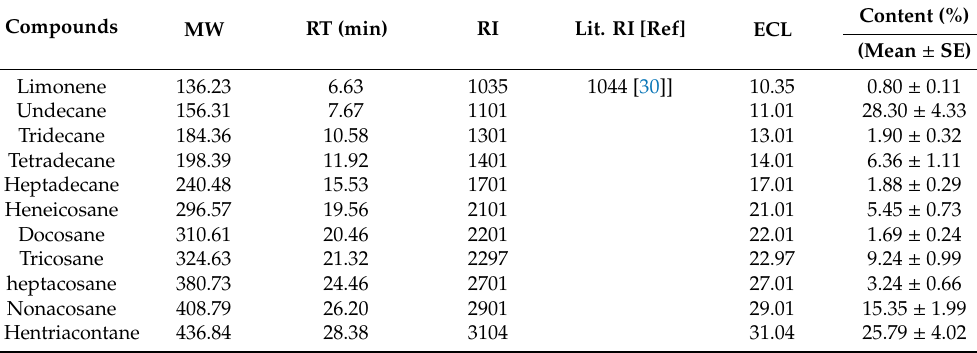
Table 6. Trail compounds of the workers of Oecophylla smaragdina